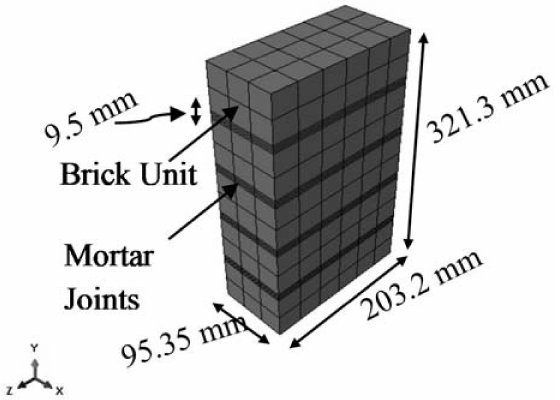
Figure 2. Numerical model of 3D prism considered for the parameter identification in this